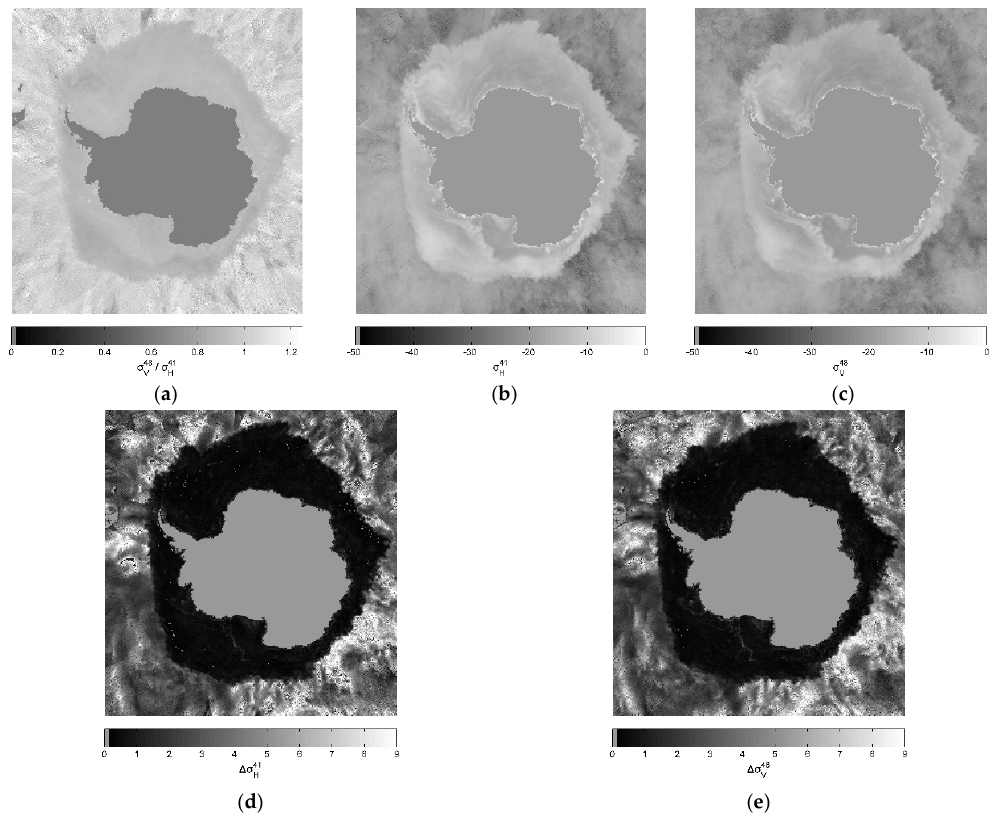
Figure 3. The mapping parameter images of ( a ) (cid:2026) (cid:3023)(cid:2872)(cid:2876) /(cid:2026) (cid:3009)(cid:2872)(cid:2869) , ( b ) (cid:2026) (cid:3009)(cid:2872)(cid:2869) , ((cid:1803))(cid:2026) (cid:3023)(cid:2872)(cid:2876) , ((cid:1804))(cid:1986)(cid:2026) (cid:3009)(cid:2872)(cid:2869) and ( e ) (cid:1986)(cid:2026) (cid:3023)(cid:2872)(cid:2876) on 20 September 2013. Antarctic images contain 332 × 316 pixels with a pixel resolution of 25 km, and its central area for land.